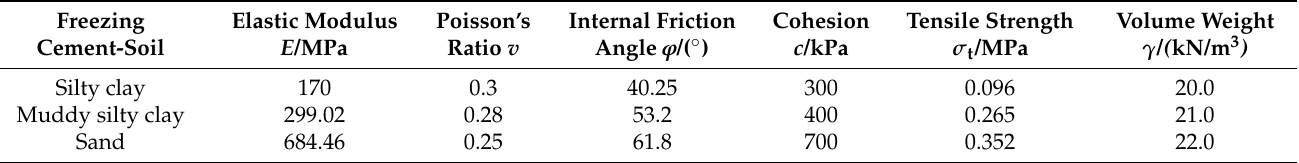
Table 3. Physical and mechanical parameters of the freezing cement-soil.